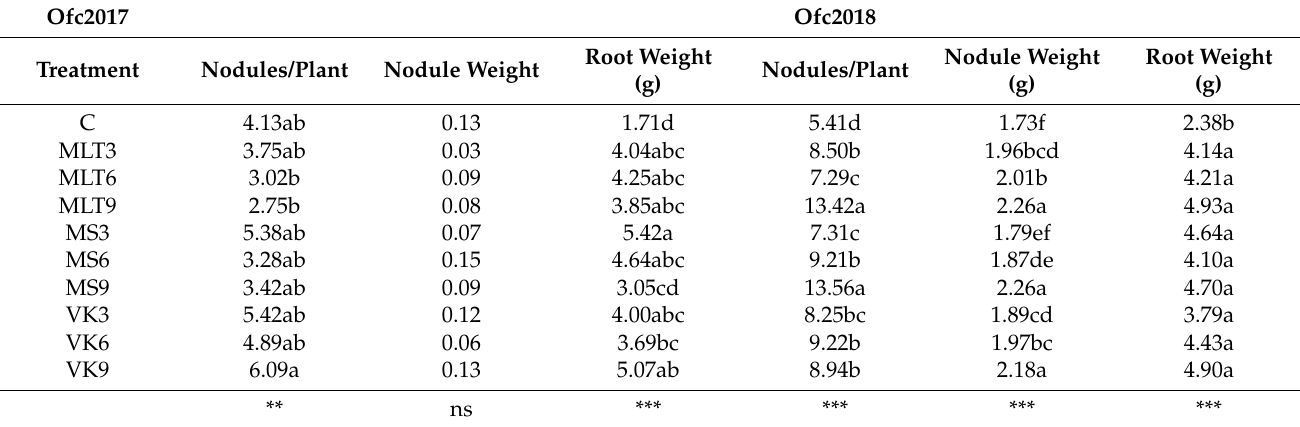
Table 8. Multiple linear regression on the factors that influence biological nitrogen fixation.